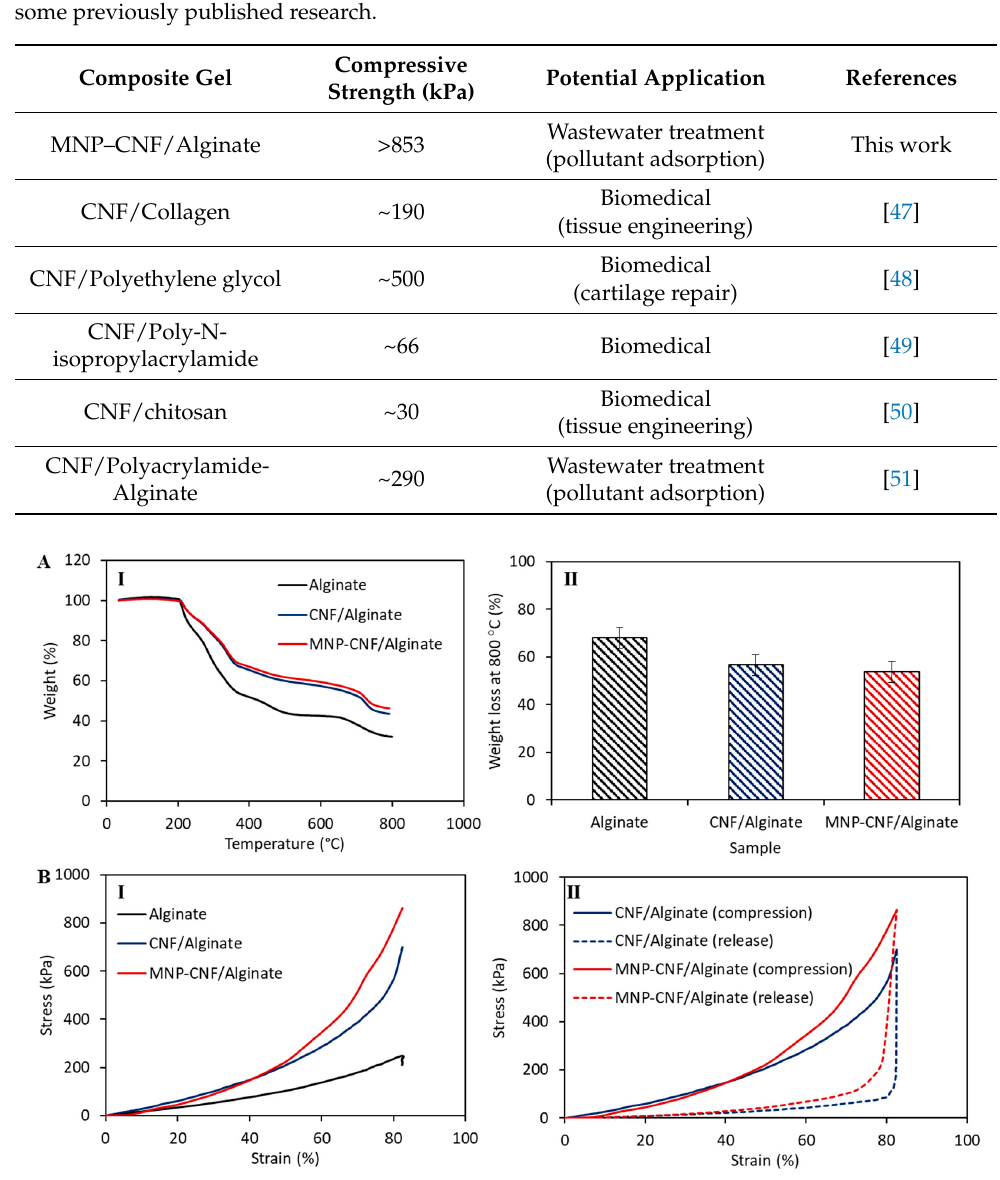
Figure 4. Thermal and mechanical properties of composite gel beads. ( A ) Thermogravimetric test results: ( I ) Thermal degradation of gel beads over 40–800 °C, ( II ) Overall weight loss at 800 °C. ( B ) Compression test results: ( I ) Stress-strain curves of different gel beads showing the differences in stiffness, ( II ). Shape recovery of hybrid gel beads after compression.